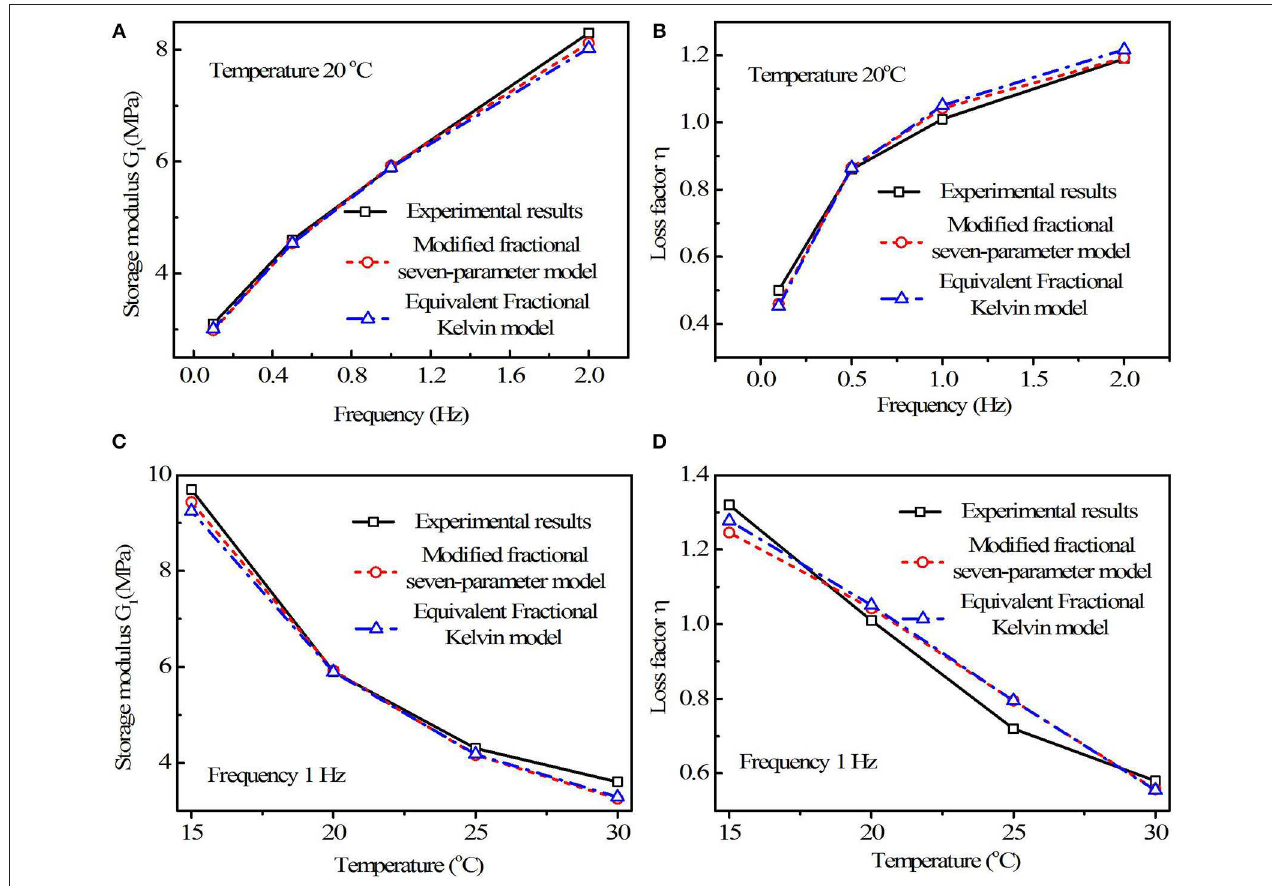
FIGURE 9 | The experimental and numerical results comparison of ZN22 viscoelastic material. (A–D) Storage modulus, loss factor, storage modulus, and loss factor,